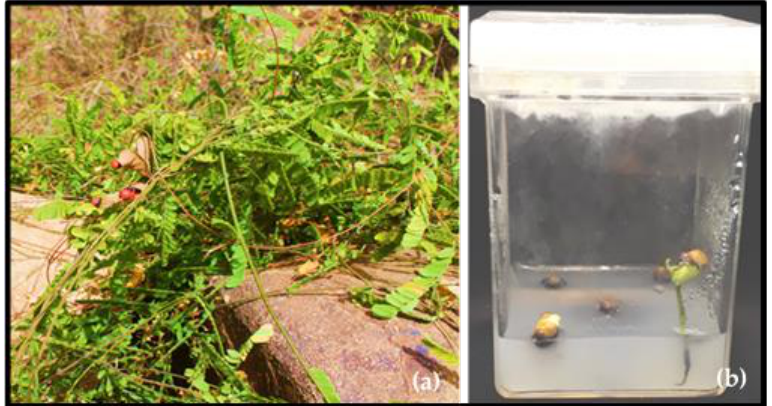
Figure 6. ( a ) Photos of Abrus precatorius collected from the Al-Baha mountains, Saudi Arabia. ( b ) the germination of the seeds.